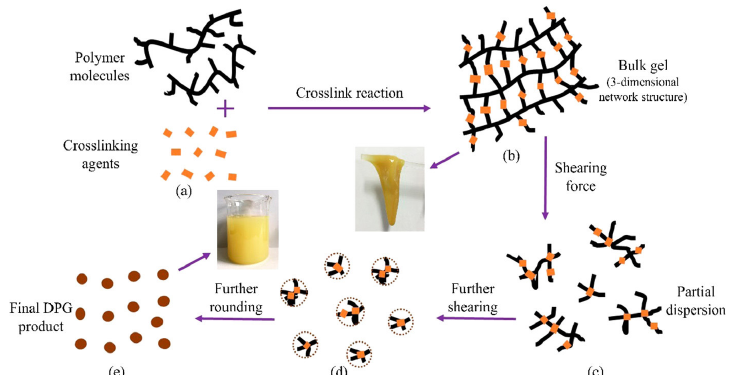
Figure 17. Preparation mechanism of DPGs. ( a – e ) the cross-linking reaction process of the bulk gel and the shearing process using the colloid mill. (Reprinted/adapted with permission from Ref. [40], 2016, Liu et al.).